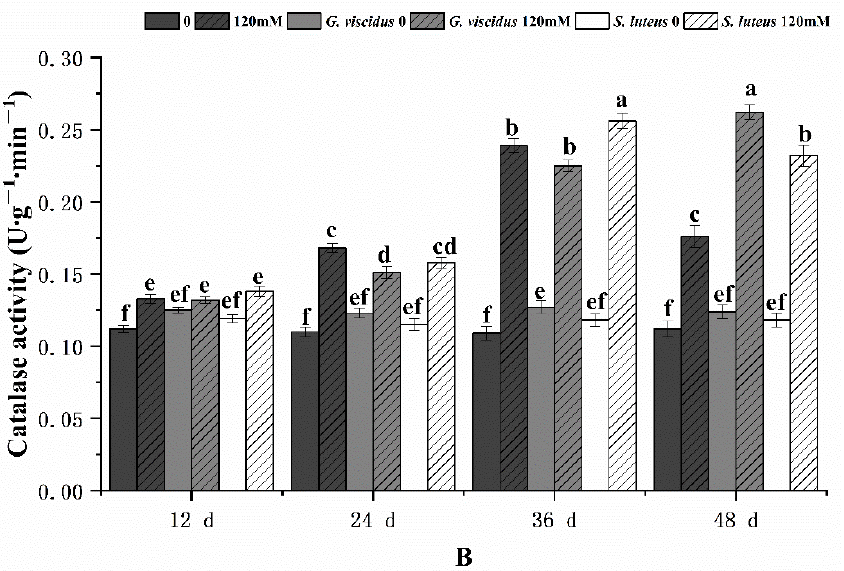
Figure 11. Changes in the POD ( A ), CAT ( B ) activity in ectomycorrhizal seedlings of Q. mongolica under NaCl stress. Bars represent means of five replicates ( ± SD). For each parameter, bars with different letters indicate significant differences among treatments, p ≤ 0.05, following one-way ANOVA.